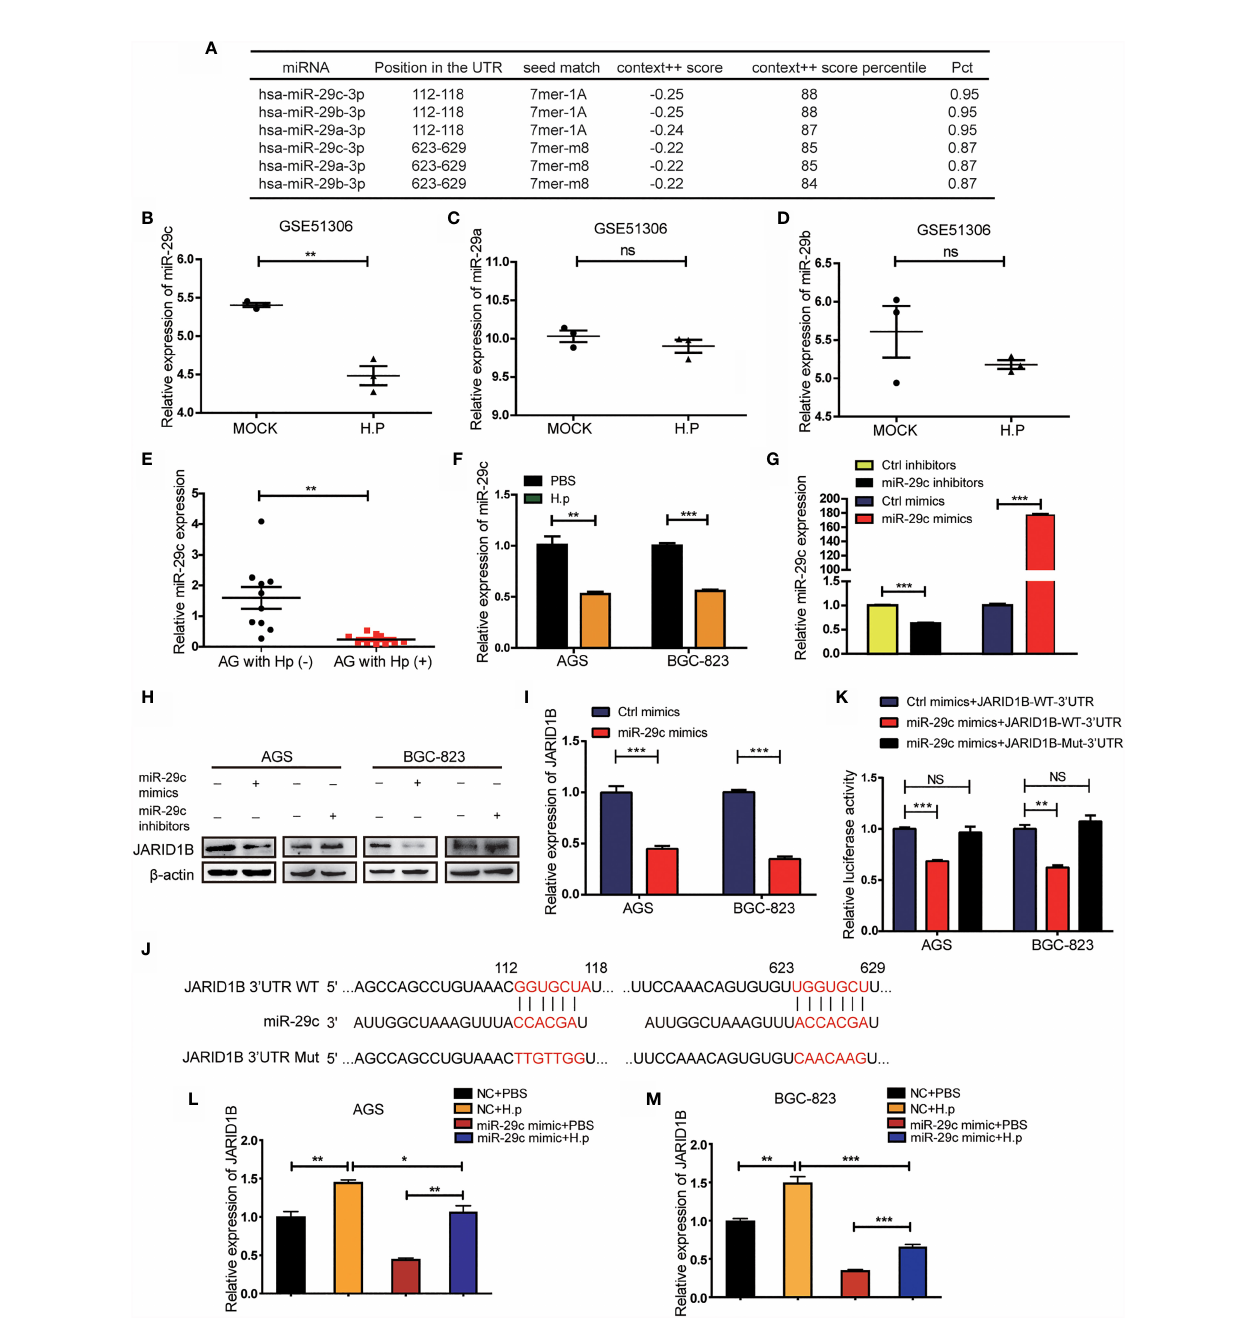
FIGURE 5 | H. pylori upregulates JARID1B expression through the downregulation of miR-29c. (A) TargetScan analysis of the microRNA that can bind to 3 ′ - untranslated region (UTR) of JARID1B. (B – D ) The expression of miR-29c, miR-29a, and miR-29b in gastric epithelial cells infected with H. pylori , data came from GSE51306. (E) RT-PCR detection of miR-29c in gastritis tissues with or without H. pylori infection. (F) RT-PCR analysis of miR-29c expression in H. pylori -infected BGC-823 and AGS. (G) Transfection ef fi ciency of transfected miR-29c inhibitors and mimics in GC cells AGS. (H) Western blot assay was performed to detect the expression of JARID1B protein in AGS and BGC-823 cells after transfection of miR-29c mimics and miR-29c inhibitor, respectively. (I) RT-PCR was used to detect the expression of JARID1B messenger RNA (mRNA) after transfection of miR-29c mimics in AGS and BGC-823. (J) The construction of the plasmid with miR-29c binding site [JARID1B-3 ’ UTR-wild type (WT)] or the binding site mutation plasmid (JARID1B-3 ′ -UTR-Mut). (K) Dual luciferase assay was performed to detect AGS and BGC-823 transfected with the miR-29c mimics and then transfected with the WT JARID1B 3 ′ -UTR reporter plasmid or the mutant JARID1B 3 ′ -UTR Mut reporter plasmid. (L, M) RT-PCR was used to detect JARID1B expression in AGS and BGC-823 of the control group, H. pylori infection group, and H. pylori infection combined with transfection of the miR-29c mimics group. All results were repeated three times. *P < 0.05; **P < 0.01; ***P < 0.001, NS, not statistically signi fi cant (Student ’ s